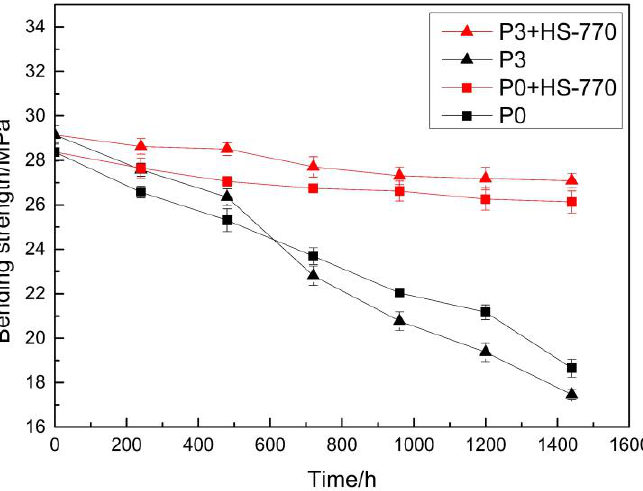
Figure 11. The effect of ultraviolet radiation time on the bending properties of the materials.